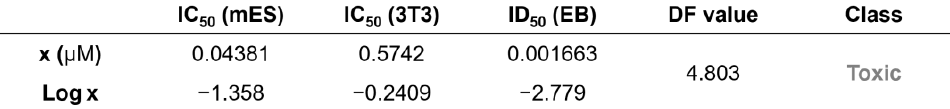
Figure 1. Developmental toxicity of D5 using EBT. Measurement of cell viability using mES and 3T3-L1 and half inhibitory concentration for EB size using mES: ( A ) IC 50 values of mES; ( B ) IC 50 values of 3T3-L1; ( C ) ID 50 values of mES; ( D ) table of EBT-derived values. All values were expressed as mean, and the R 2 value refers to the difference between the first value and the second value.